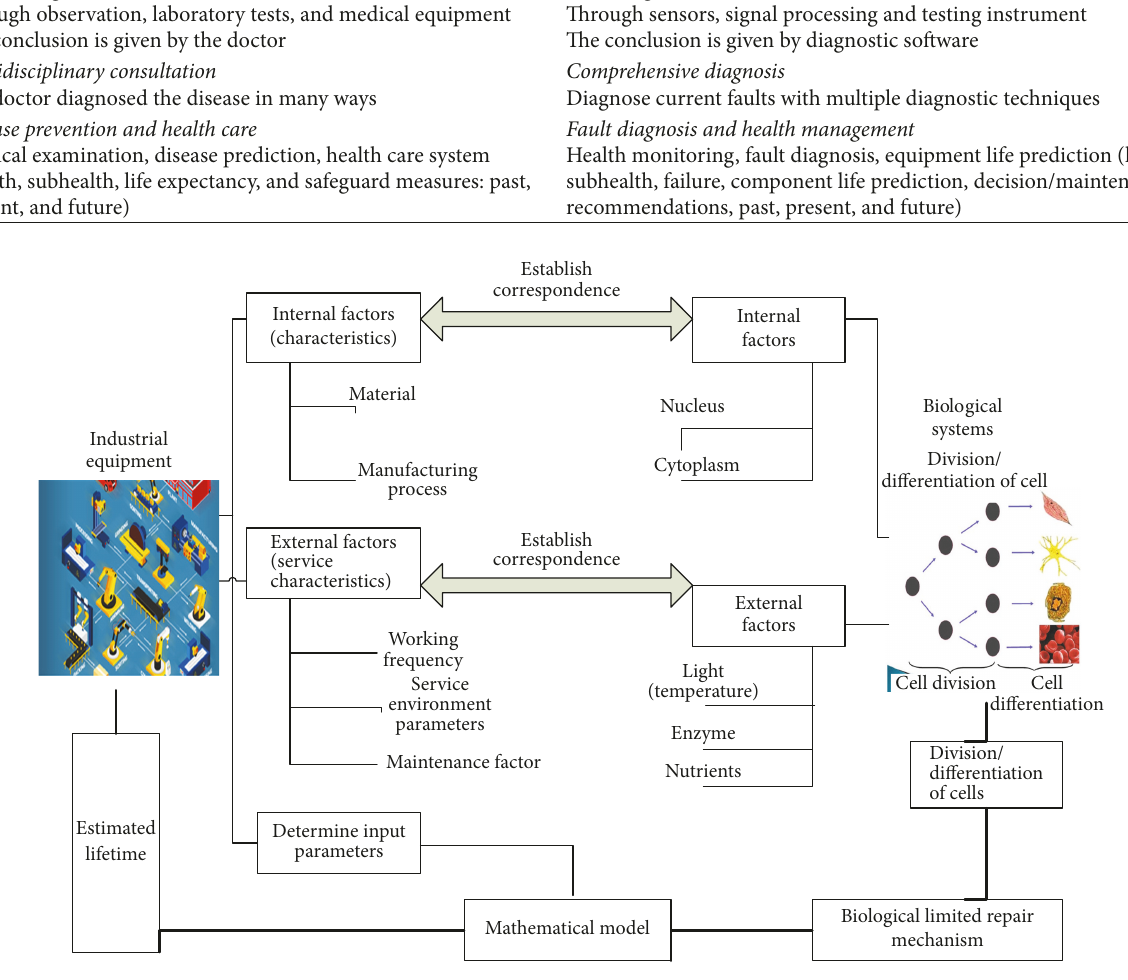
Figure 1: A schematic diagram of biological cell finite splitting mechanism and industrial equipment life